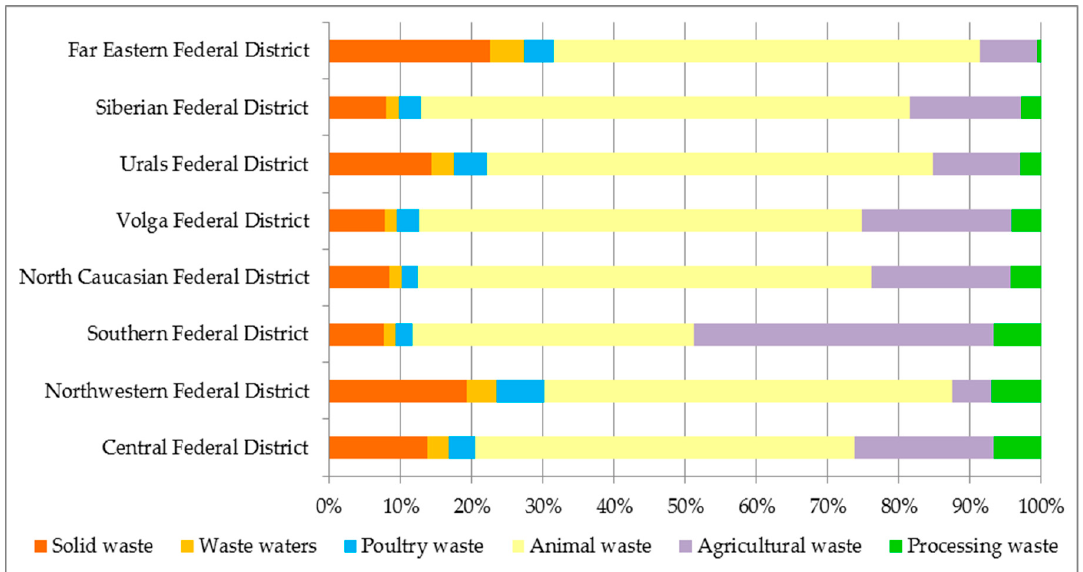
Figure 6. Structure of gross potential of organic wastes in Russian regions, thousand tons per year